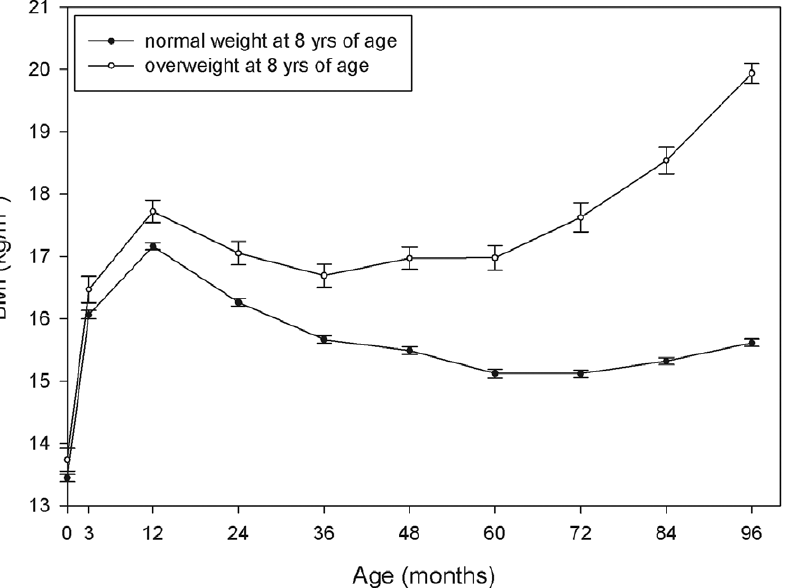
Figure 1. Mean (95% CI) BMI from birth to 8 years (96 months) of age for normal weight versus overweight children at 8 years of age.